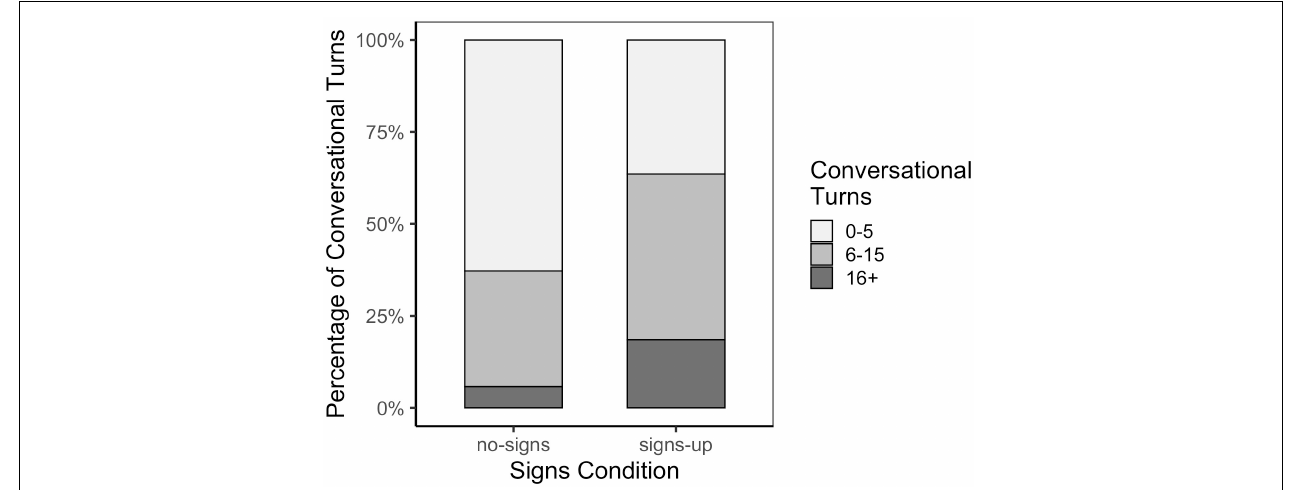
FIGURE 2 | Percentage of conversational turns across the baseline with no-signs versus the signs-up